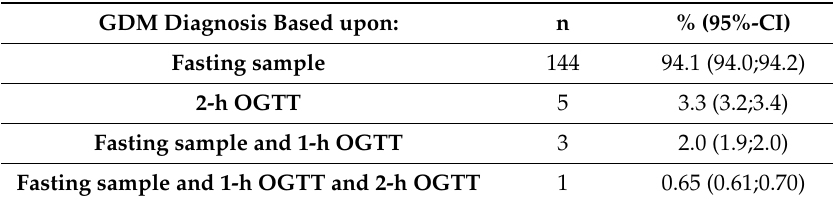
Table 2. Percent of GDM diagnosed by each glucose